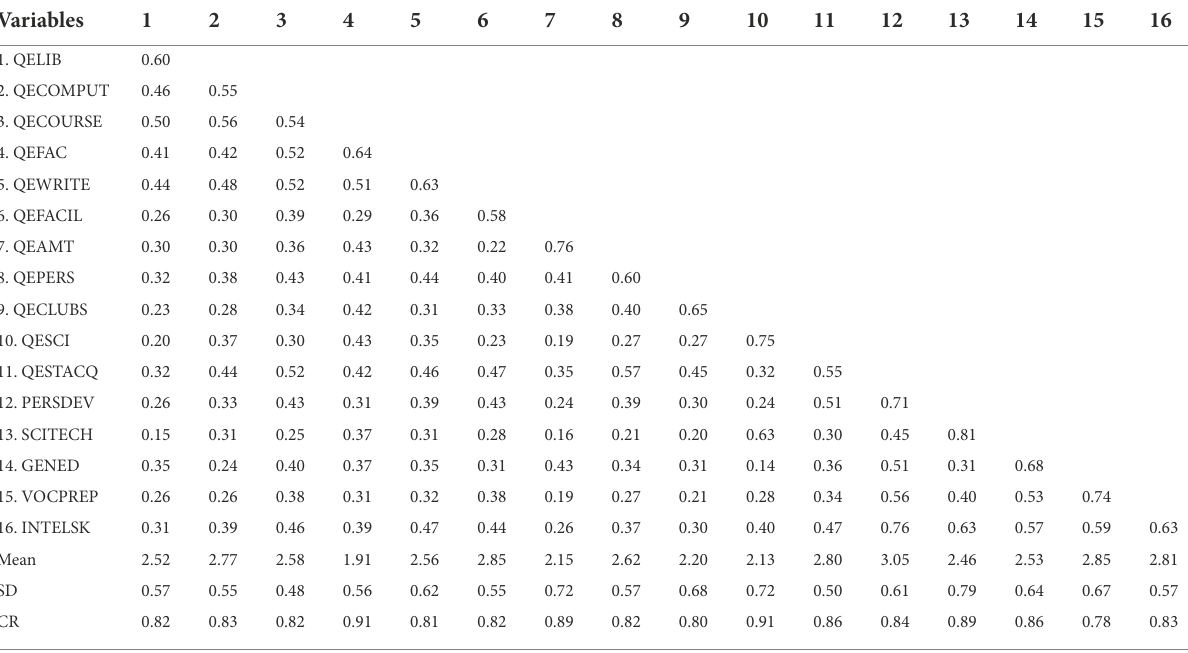
TABLE 1 Correlations for scale